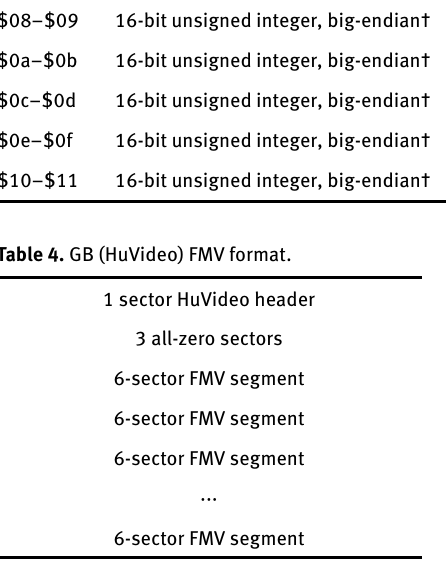
Table 5. GB (HuVideo) FMV segment